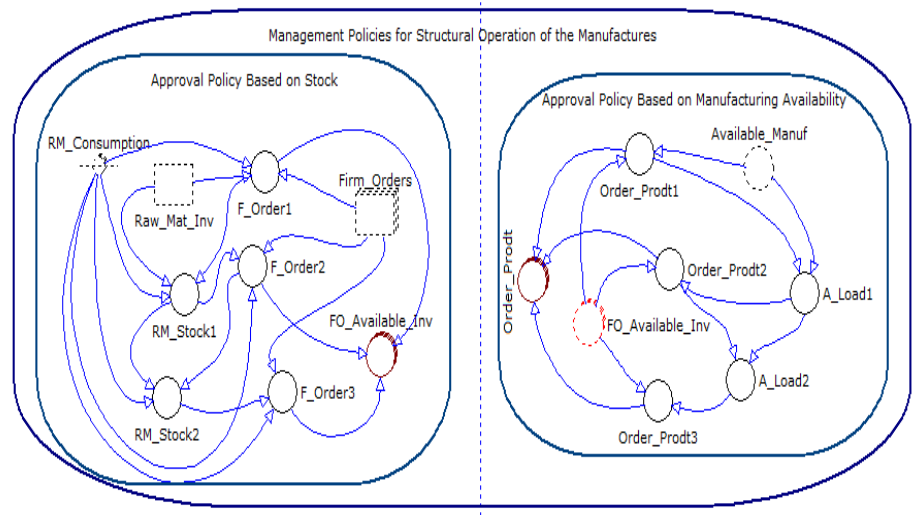
Figure 4. Structural performance policies of the model. Reprinted with permission from Nuñez- Rodriguez, et al. [1]; published by Processes, 2021.